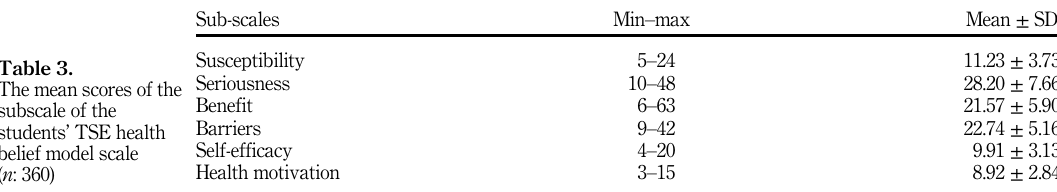
Table 3. The mean scores of the subscale of the students ’ TSE health belief model scale ( n : 360)